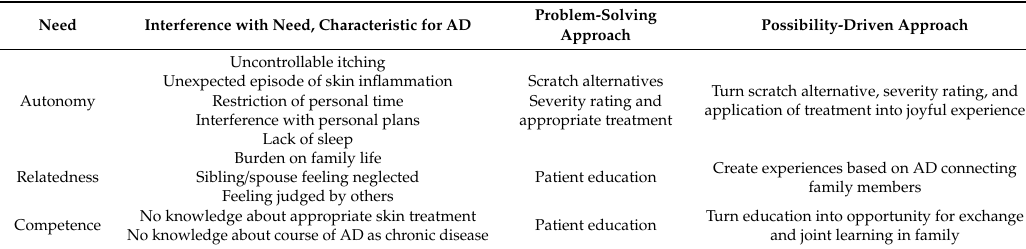
Table 1. Atopic dermatitis (AD), conflicts with needs, and intended solutions (problem-solving approach and possibility-driven